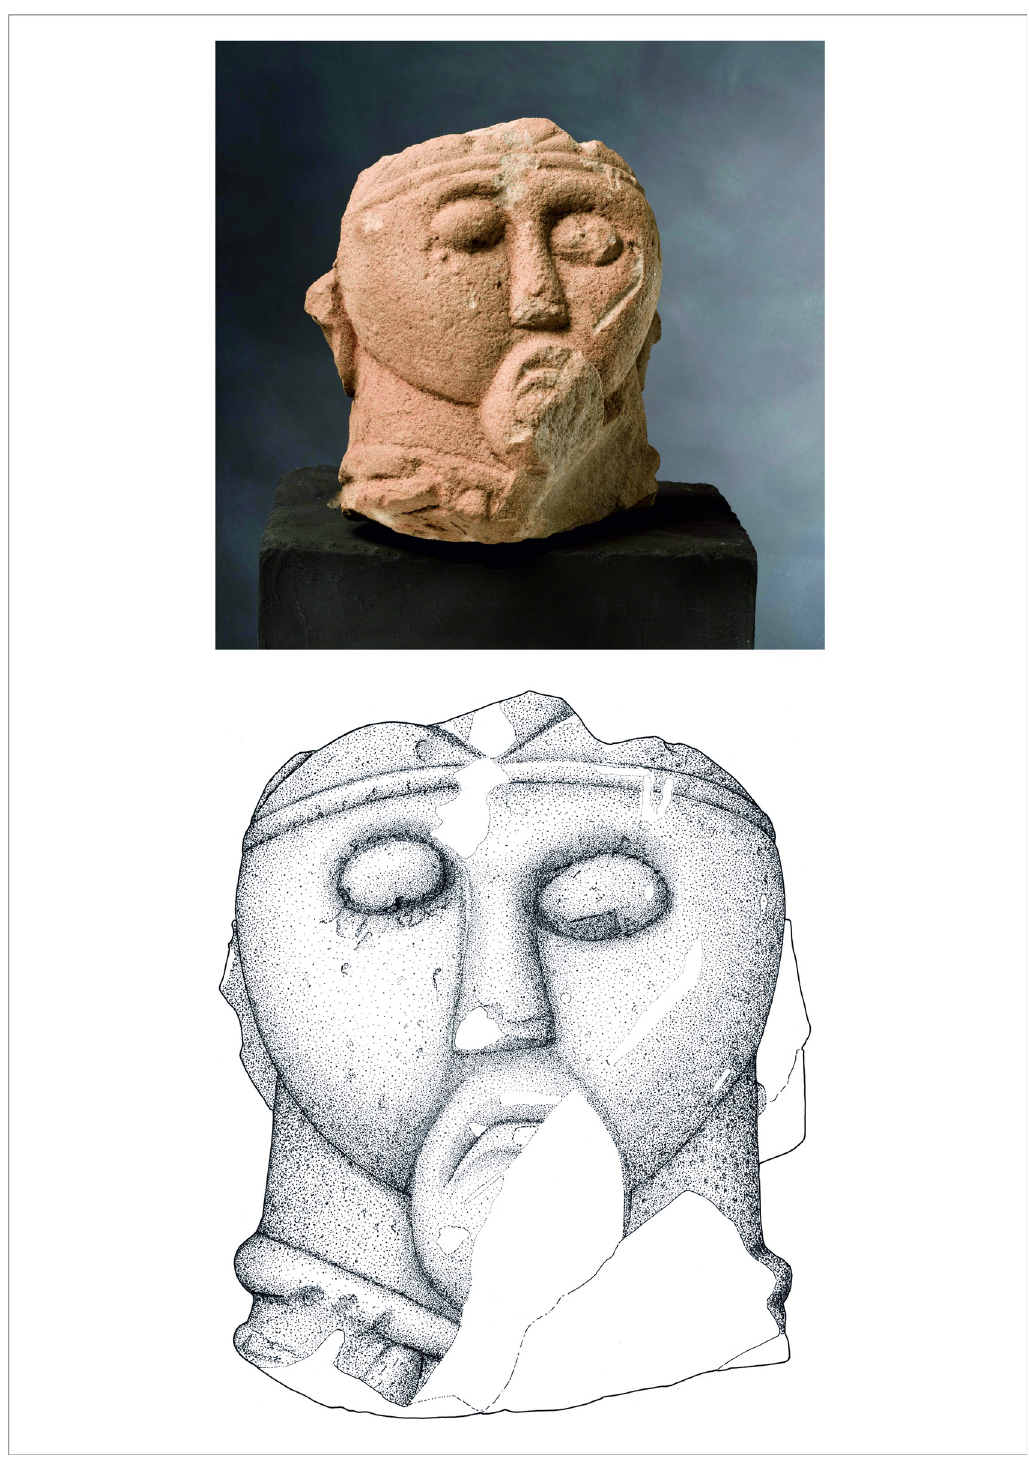
Fig 4. Fragment (head) of a sandstone statue (statue 3) from the Glauberg (photo: P. Odvody, hessenARCHA ¨ OLOGIE; drawing: Pilar Rispa).